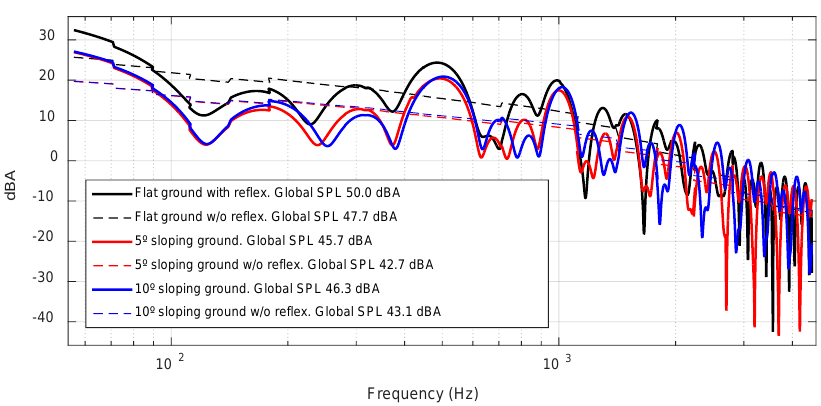
Figure 30. Influence of sloping and reflecting grounds on the SPL spectrum for the ‘Car–Person’ configuration and barrier with optimum double Y caps.